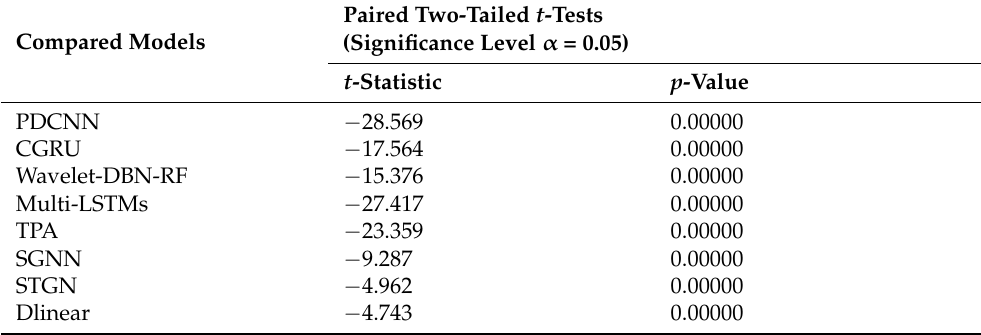
Table 8. The results of the statistical tests.